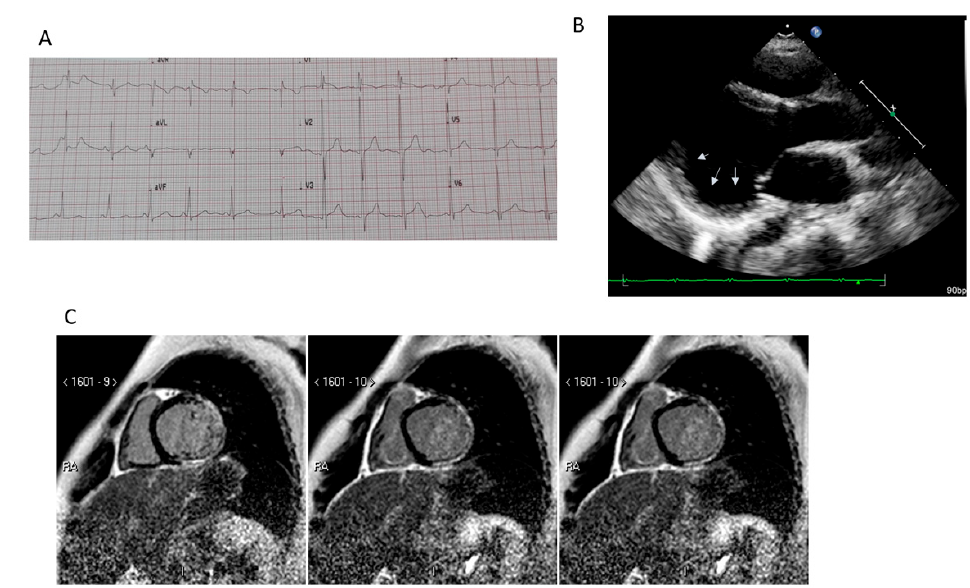
Figure 1. Clinical features of Duchenne muscular distrophy cardiomyopathy (DMD-DCM). Panel ( A ): typical EKG with sinus tachycardia and tall R waves. Panel ( B ): parasternal long axis view of left ventricle (LV). Arrows indicate the presence of posterior wall aneurysm. Panel ( C ): cardiac magnetic resonance: short axis view of the LV. Presence of a transmural late gadolinium enhancement pattern located at the infero-lateral wall (Courtesy of Dr. A. Secinaro).